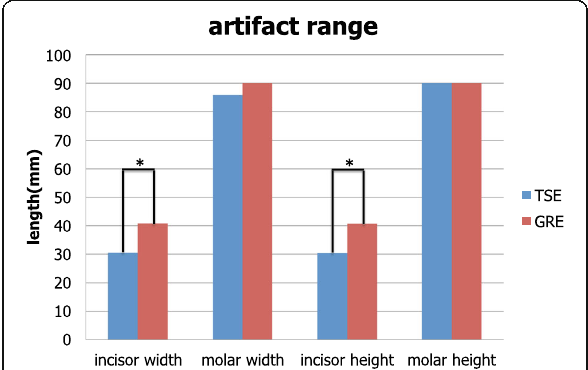
Table 6 The relationship between number of measurable